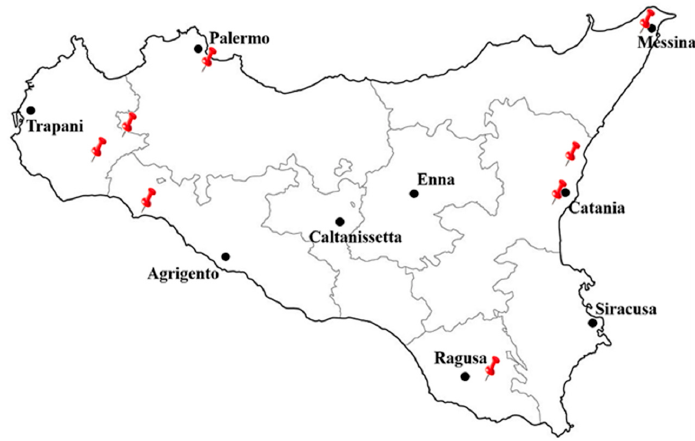
Figure 1. Drawing pins indicates the areas from where the honey samples have been acquired.